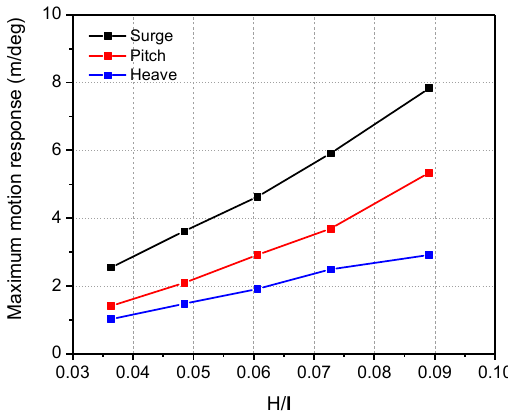
Figure 19. Maximum and minimum value of 3 DOF motion under different focused waves.